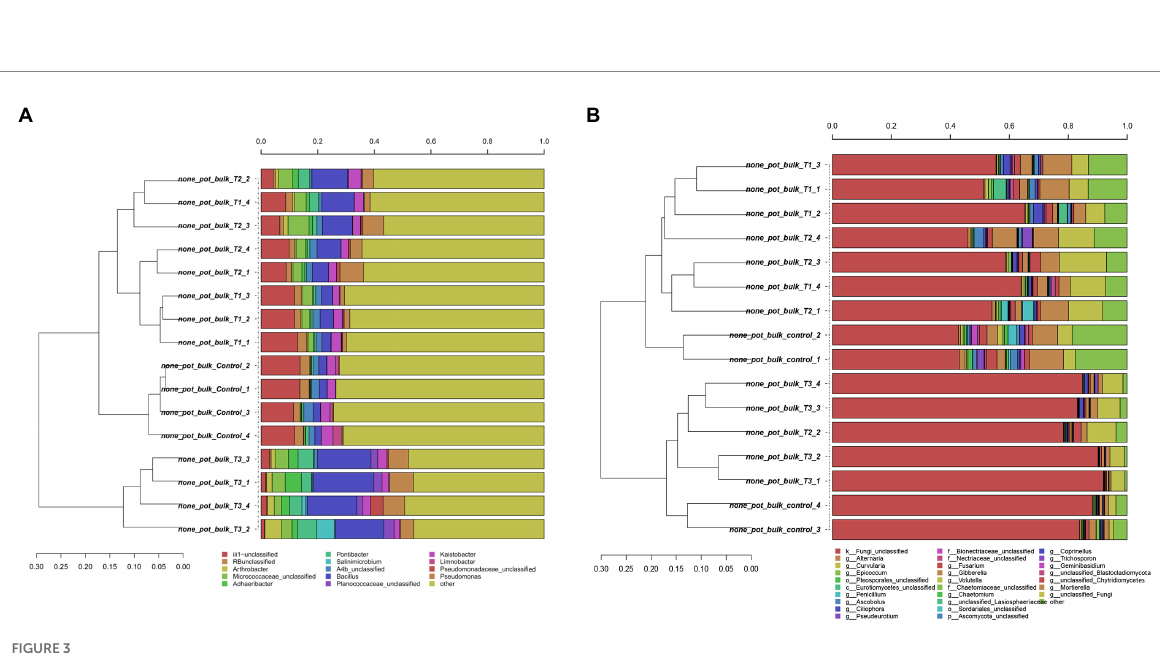
FIGURE 3 Hierarchical cluster classification at genus level for bacterial (A) and fungal (B) taxa contributing at more than 5% in at least one sample. Taxa contributing with a lower threshold are added to the “other” sequence